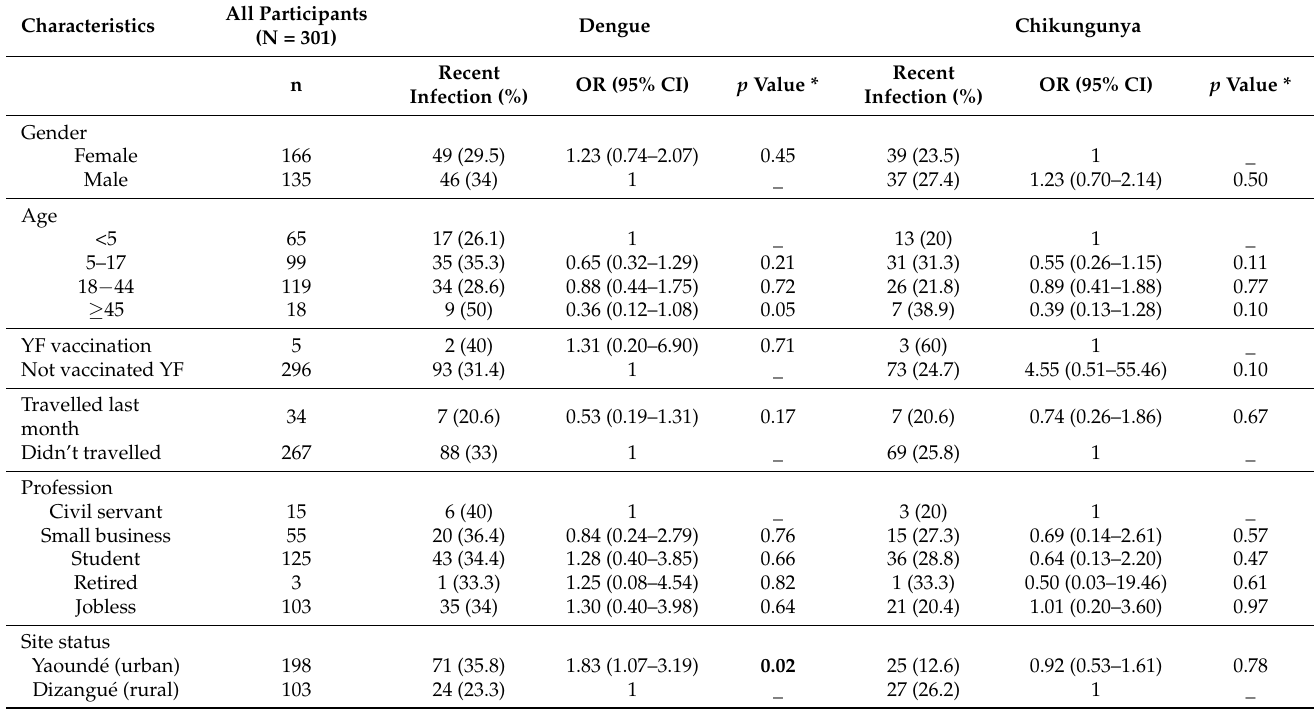
Table 2. Association between demographic characteristics of the patients and recent infection with dengue and chikungunya.